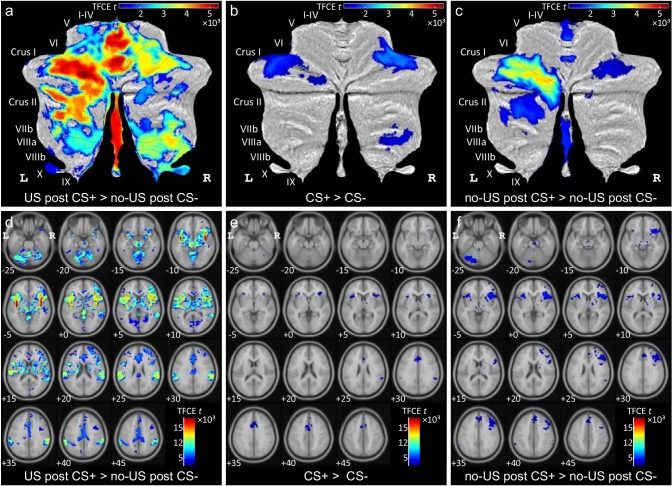
Diffential activations during fear acqusition.(a–c) Differential cerebellar activations during fear acquisition in SUIT space projected on a cerebellar flatmap (Diedrichsen and Zotow, 2015). (d–f) Corresponding differential whole brain activations in MNI normalized space. All contrasts collapsed over early and late acquisition blocks and calculated using TFCE and familywise error correction (p<0.05). CS = conditioned stimulus; L = left; MNI = Montreal Neurological Institute standard brain; R = right; SUIT = spatially unbiased atlas template of the cerebellum; TFCE = threshold-free cluster-enhancement; US = unconditioned stimulus.